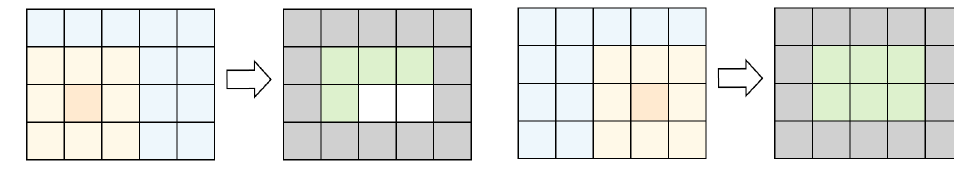
Figure 4. The convolution process by moving the